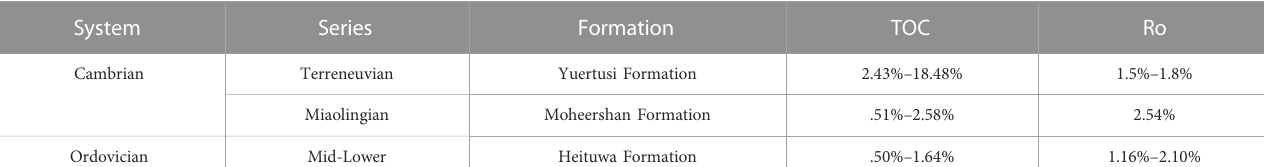
TABLE 1 Source rock parameters. System